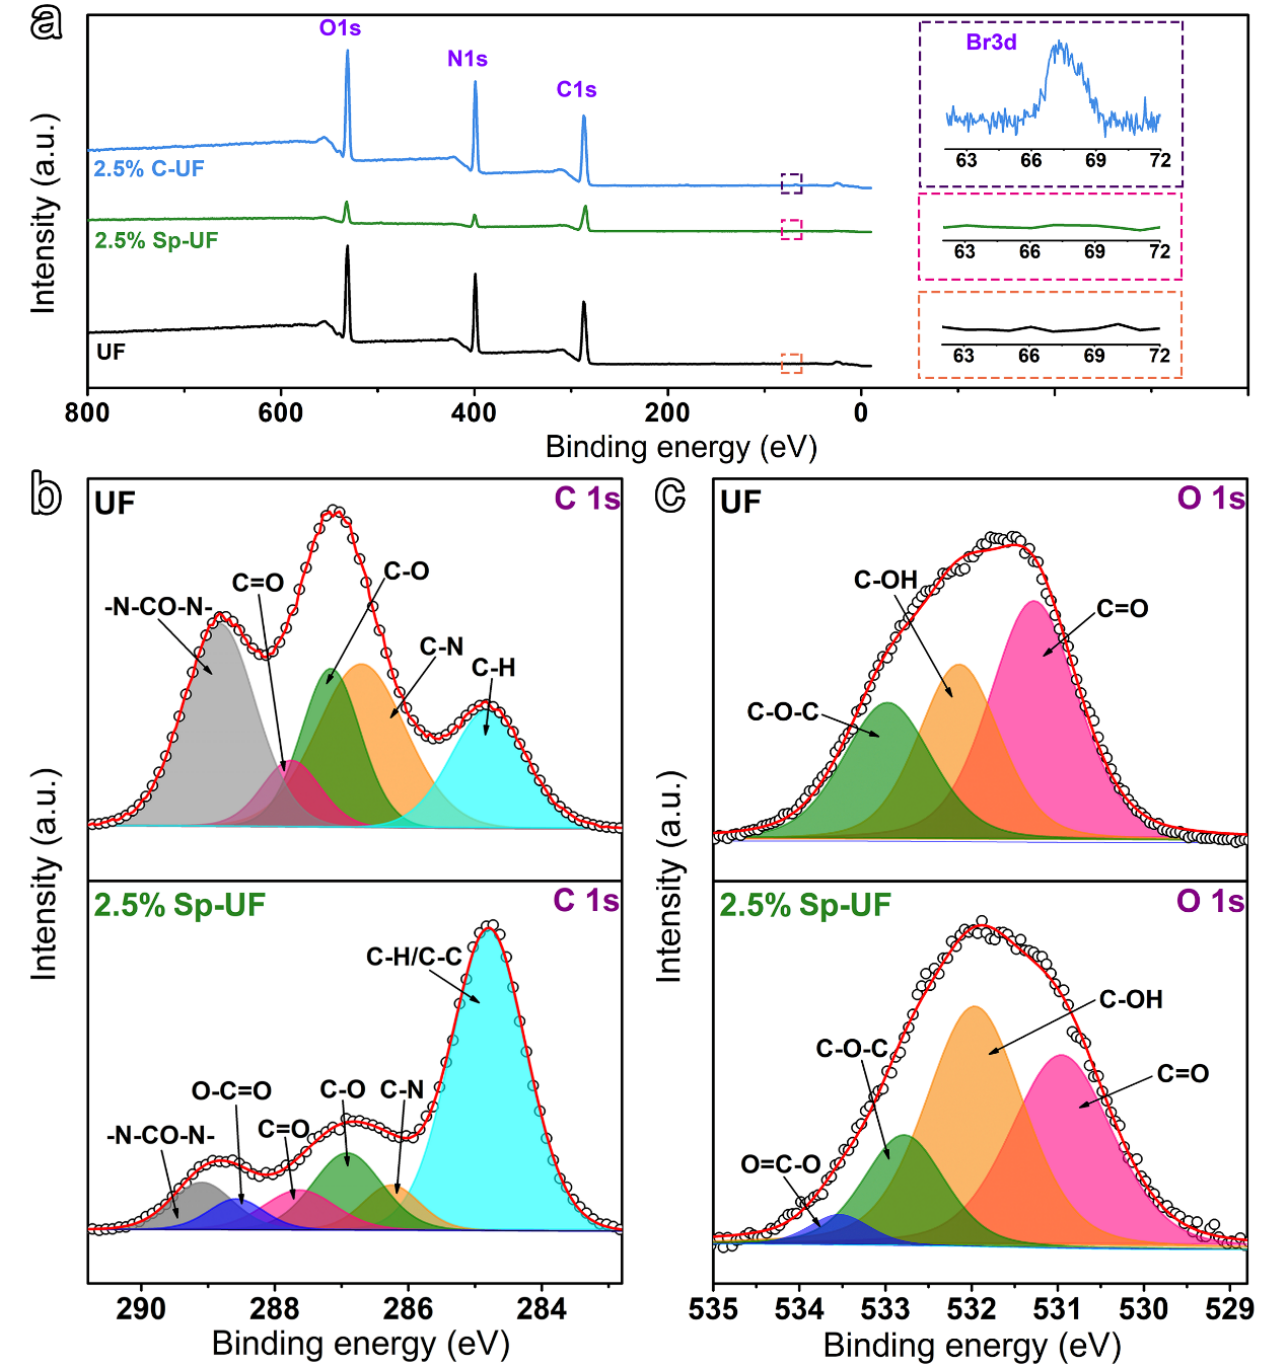
Figure 6. ( a ) XPS full spectra of the cured UF, 2.5% Sp-UF, and 2.5% C-UF resins. High-resolution ( b ) C 1s, and ( c ) O 1s XPS spectra of the UF and 2.5% Sp-UF resins.